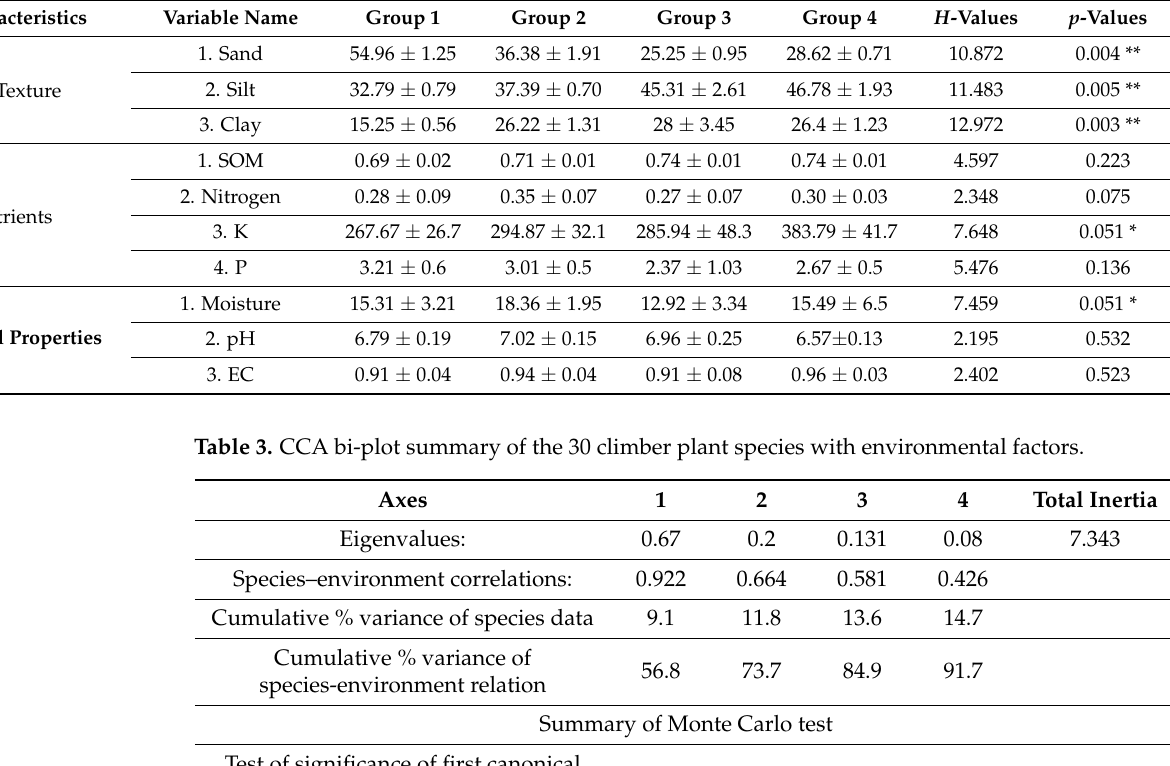
Table 2. Mean values ± SE of the edaphic parameters (soil texture, nutrients, and soil chemical properties) based on the four groups acquired from Ward’s cluster analysis using the climber sampling data. (Mean ± SE). The four groups have different soil properties and four different indicator species. Non-parametric Kruskal–Wallis test followed by Tukey HSD was used to determine whether there was a significant difference between the soil properties of the four groups. * ( p < 0.05); ** ( p < 0.01).